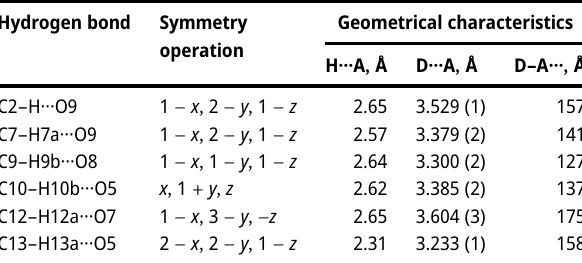
Table  : Fractional atomic coordinates and isotropic or equivalent isotropic displacement parameters (Å  ).